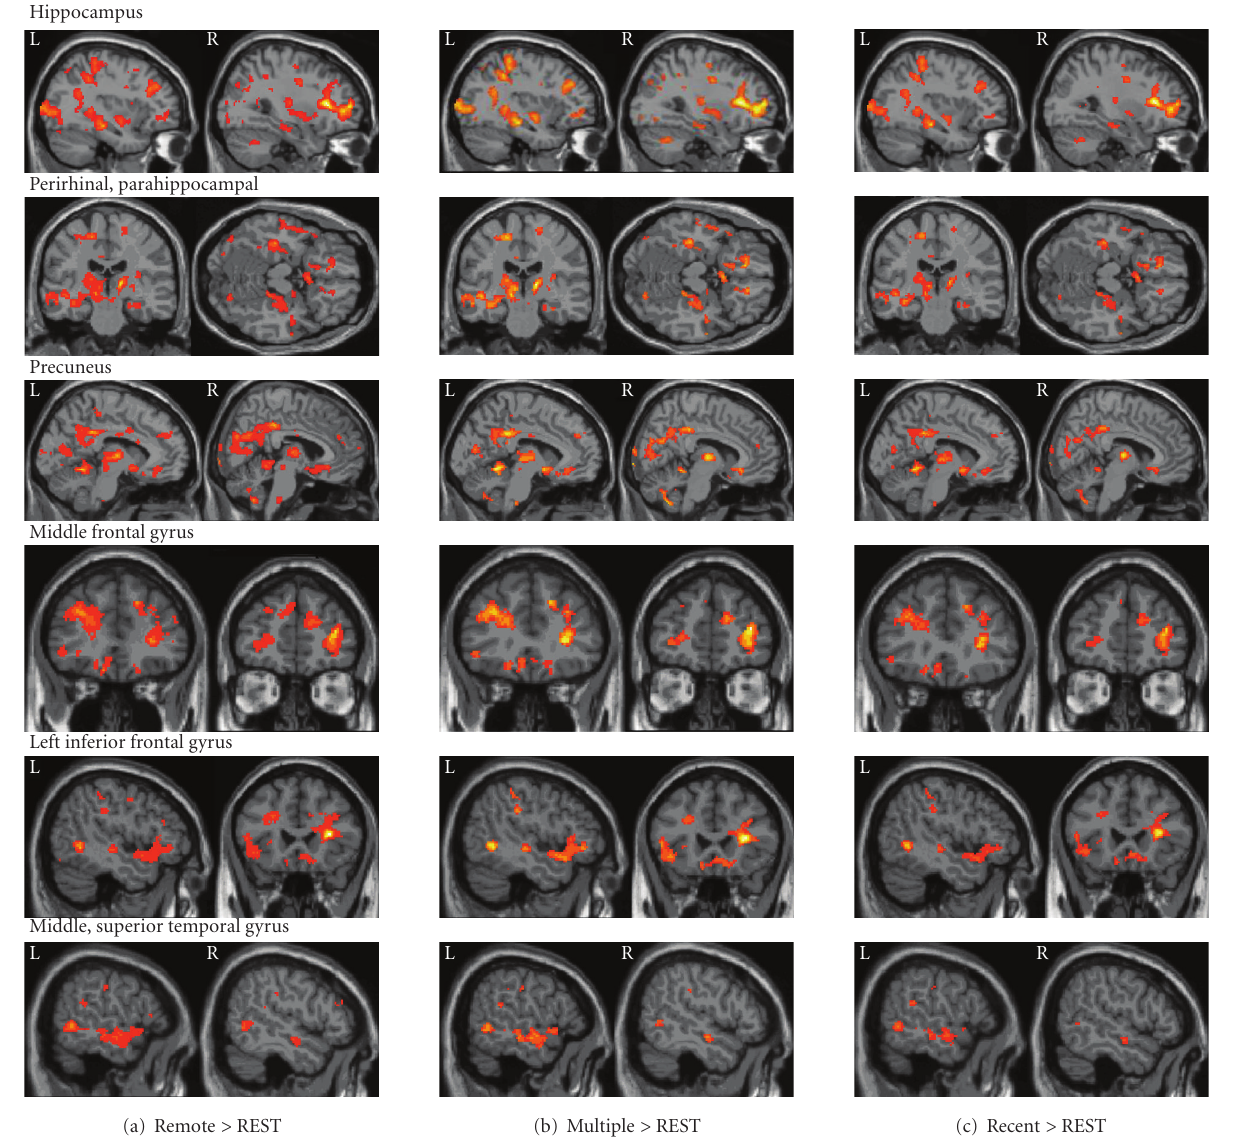
Figure 4: Memory conditions > REST ( P < .005). Each of the retrieval conditions contrasted with REST resulted in common activation patterns throughout the brain, including the hippocampus bilaterally, bilateral perirhinal and parahippocampal gyri, bilateral precuneus, bilateral middle frontal gyrus, left-lateralized inferior frontal gyrus, and bilateral middle and superior temporal